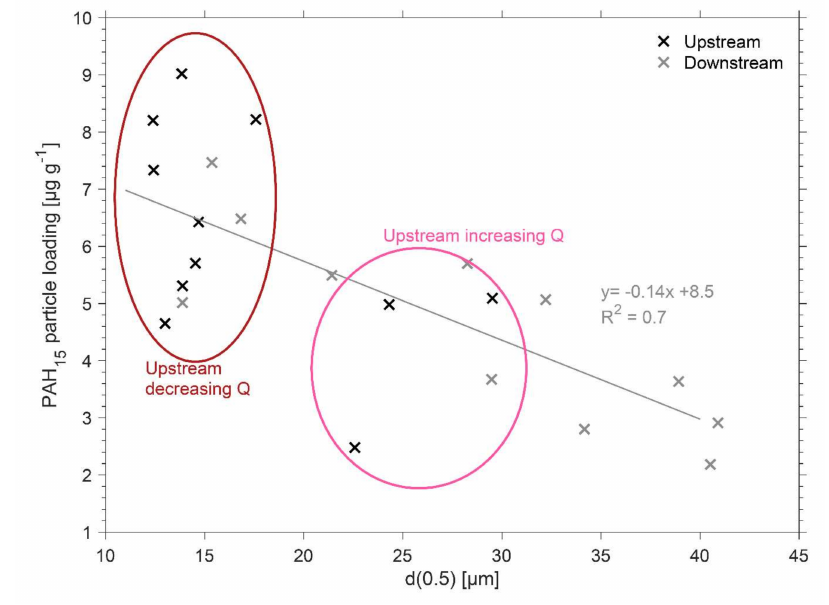
Figure 6. Relationship between PAH 15 particle loading ( µ g g − 1 ) and median particle size ( µ